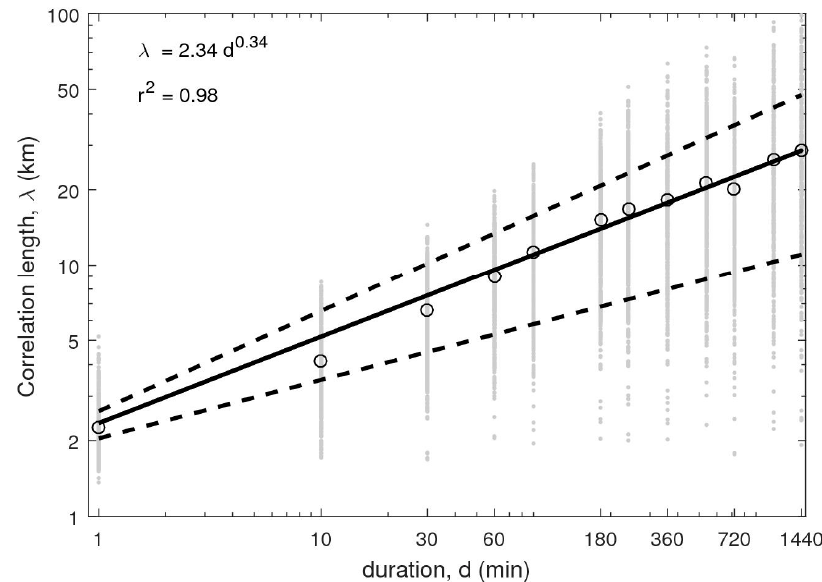
Figure 5. ARF for durations of 360 min. Dashed lines are the confidence limits (mean +/ − std. dev.) of the fitted ARF .